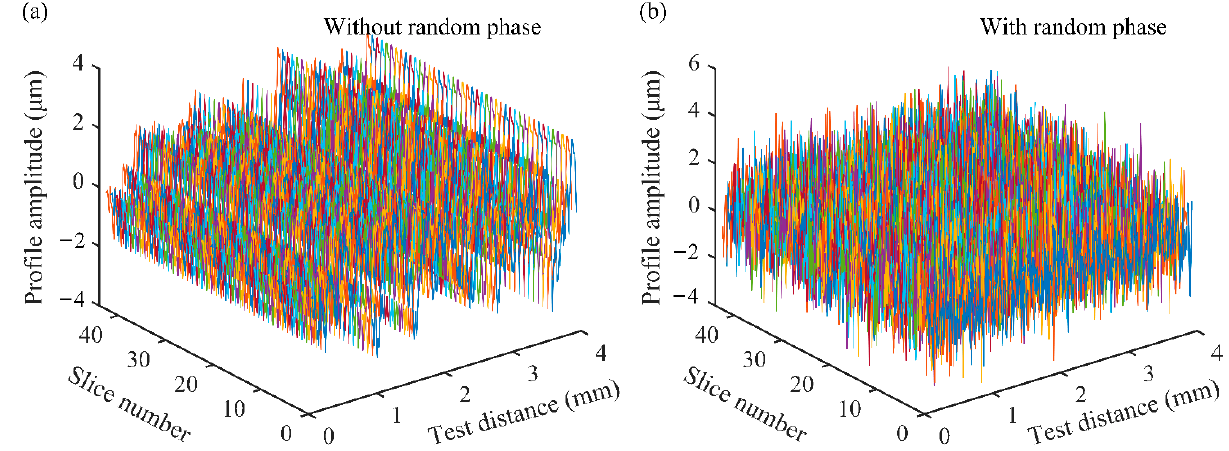
Figure 4. The 3D topography of tooth surface of spur gear pair: ( a ) without random phase; ( b ) with random phase.